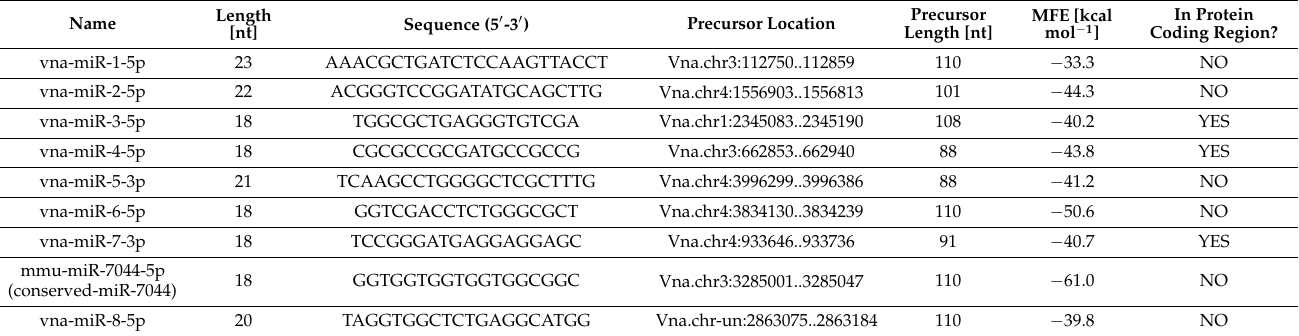
Table 2. Identified and confirmed V. nonalfalfae milRNAs with the characteristics of the precursor